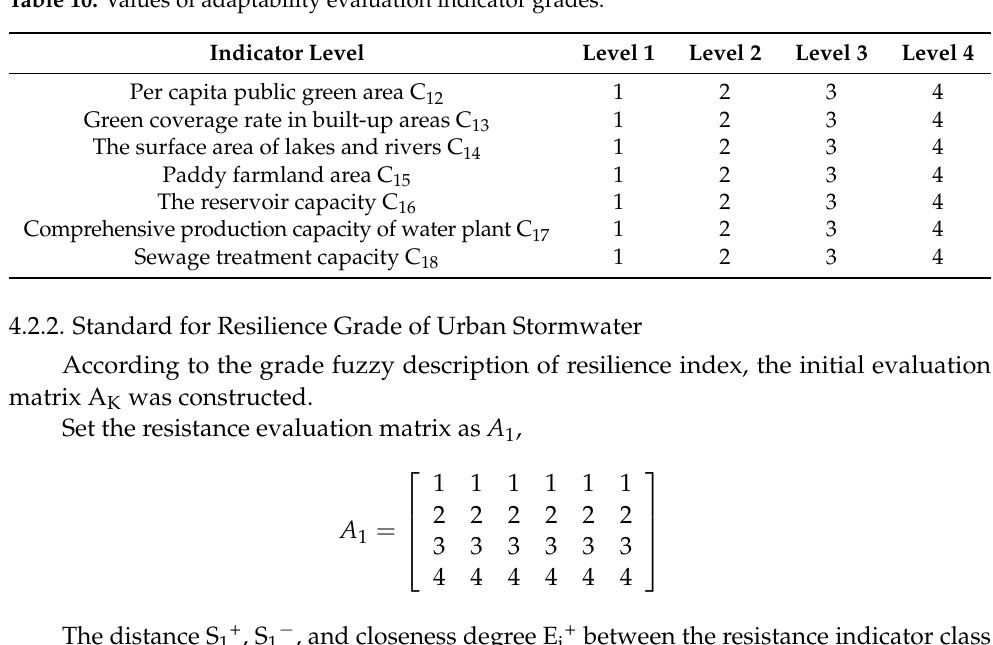
Table 10. Values of adaptability evaluation indicator grades.